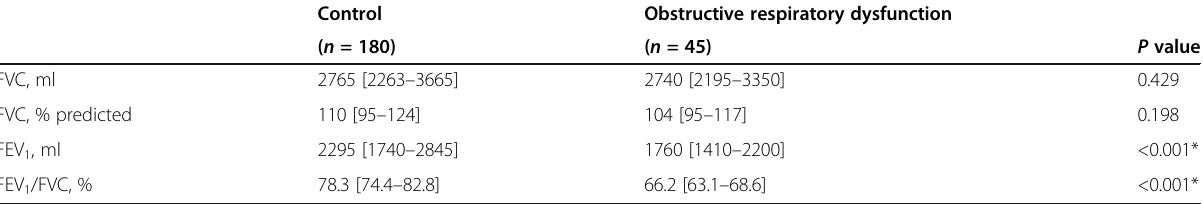
Table 1 Preoperative respiratory function